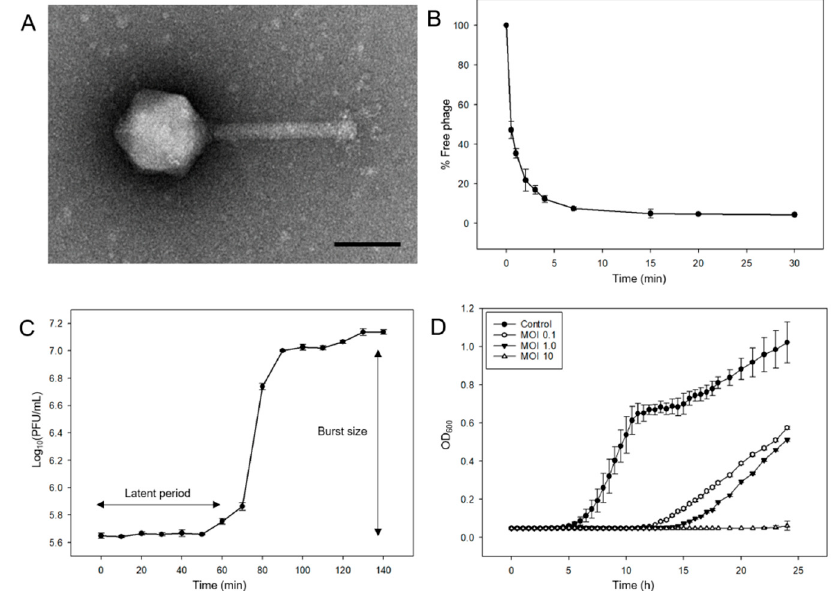
Figure 1. Morphological and biological features of phage pSal-SNUABM-04. ( A ) Transmission electron micrograph of pSal-SNUABM-04. Scale bar = 100 nm. ( B ) Adsorption assay of pSal-SNUABM-04 to host strain Sal-SNUABM-svn1. ( C ) One-step growth curve of pSal-SNUABM-04 to host bacterial strain. ( D ) In vitro planktonic cell lysis efficacy assay of pSal-SNUABM-04 at MOI of 0.1, 1, and 10 against host bacterial strain.